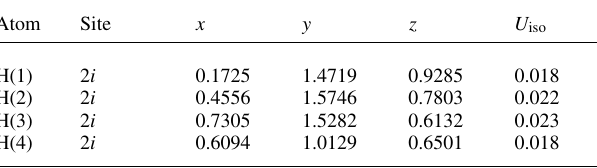
Table 2. Atomic coordinates and displacement parameters (in Å 2 )